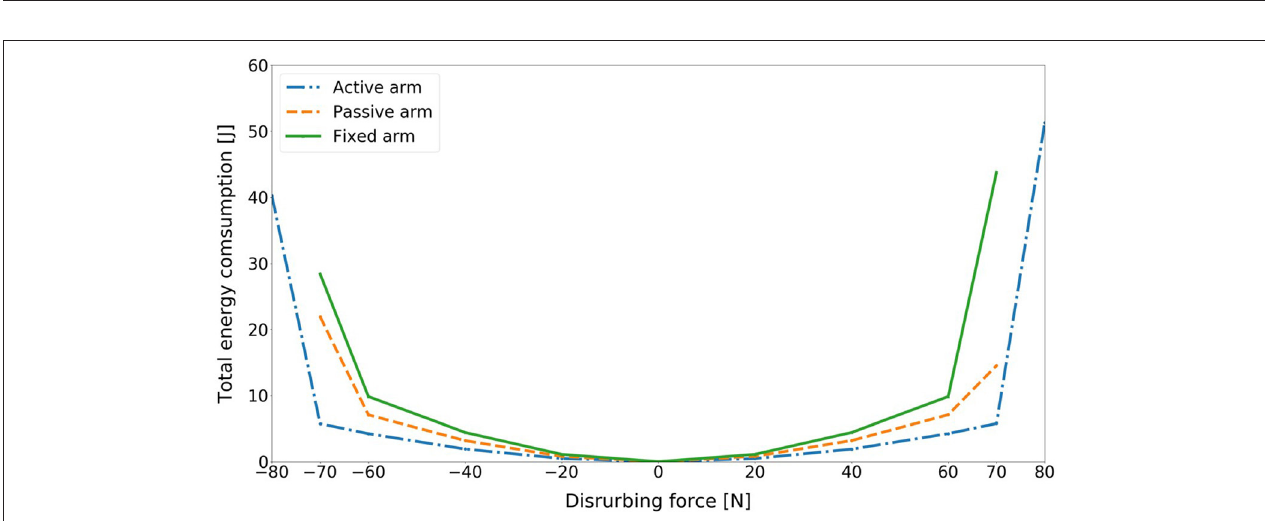
FIGURE 8 | Comparison of total energy consumption of the model for three different arm states (active arm, passive arm, fixed arm) for different disturbing forces: (1) Push backward: − 20 [ N ], − 40 [ N ], − 60 [ N ], − 70 [ N ], and − 80 [ N ]; (2) No force: 0 [ N ]; (3) Push forward: 20 [ N ], 40 [ N ], 60 [ N ], 70 [ N ], and 80 [ N